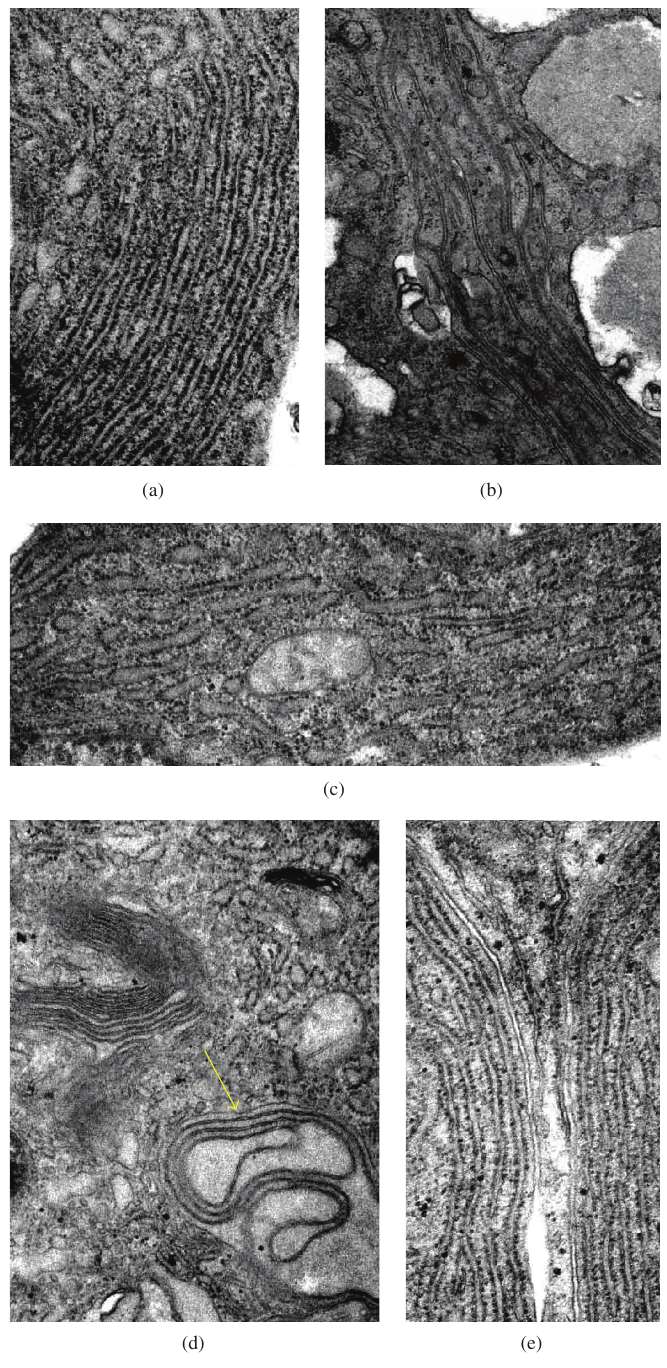
FIGURE 5: Ultrastructural changes in the hepatopancreas of B. aeruginosa exposed to the suspension of M. aeruginosa and mixed algae, respectively. (a) rER of control snail, 60000x. (b) The swelling and degranulation of rER in the mixed group at 15 days postexposure, 40000x. (c) The fragmentation of rER in the mixed group at 15 days postexposure, 40000x. (d) The whirling of rER (yellow arrow) in the mixed group at 10 days postexposure, 40000x. (e) The recovery of rER in the cyanobacterial group after 10 days of detoxification,